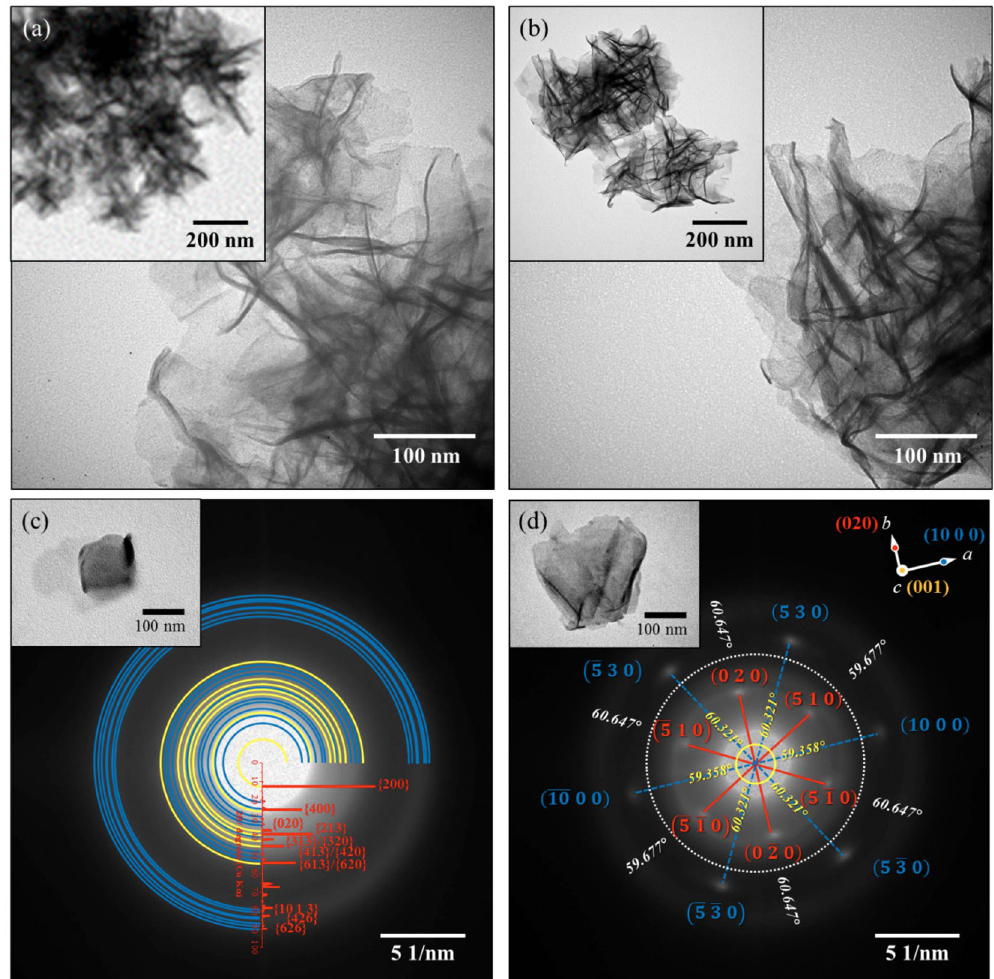
Figure 2. ( a , b ) TEM images and ( c , d ) SAED pattern of ( a , c ) un-annealed and ( b , d ) annealed samples. In ( a , b ) the inset images correspond to the low magnification images. In ( c , d ) the inset images indicate the TEM images of the analyzed area. In ( c ) the inset graph is the calculated XRD spectrum of orthorhombic δ -MnO 2 (K 0.33 MnO 2 ·0.66H 2 O) 34